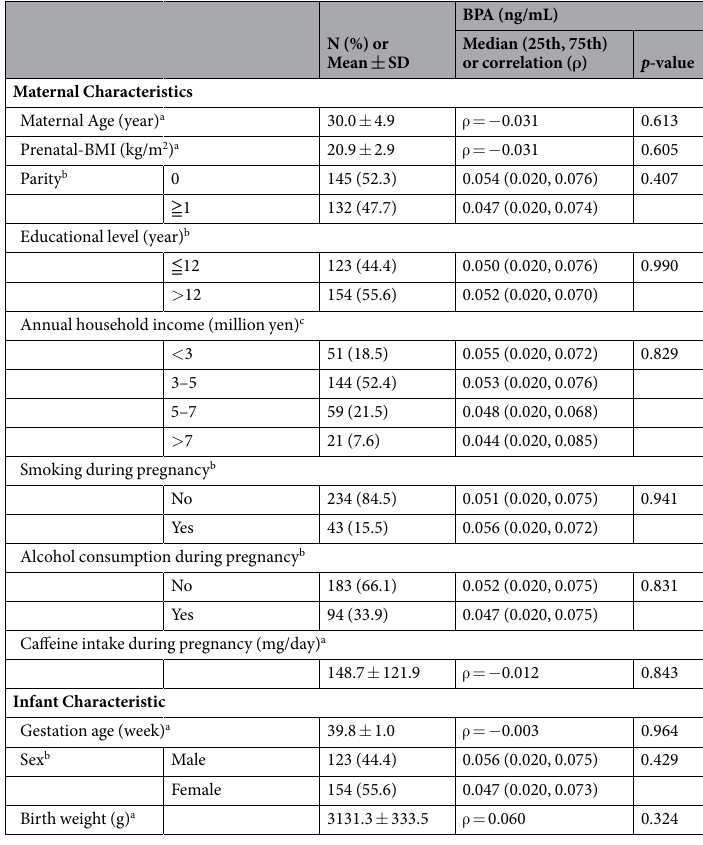
Table 1. Cord blood BPA concentrations (ng/mL) in relation to the characteristics of mothers and infants. a Spearman’s correlation test ( ρ ), b Mann-Whitney U-test, c Kruskal-Wallis